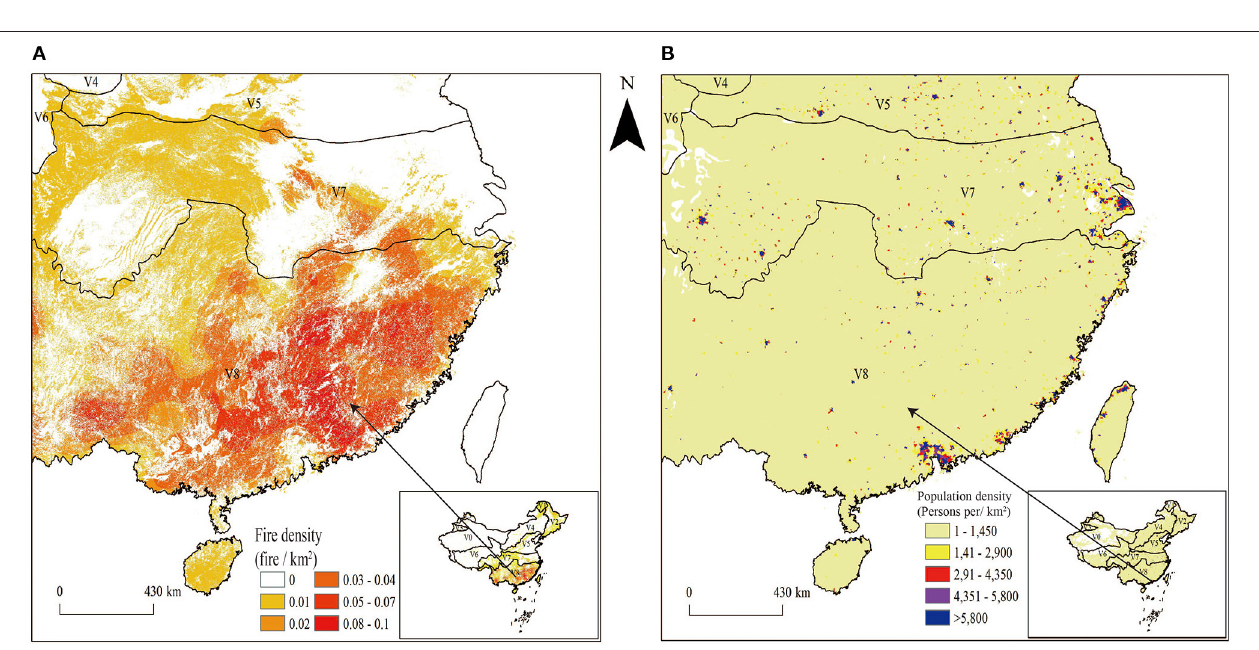
FIGURE 3 | Spatial pattern of fire density and population density. (A) fire density map; (B) population density